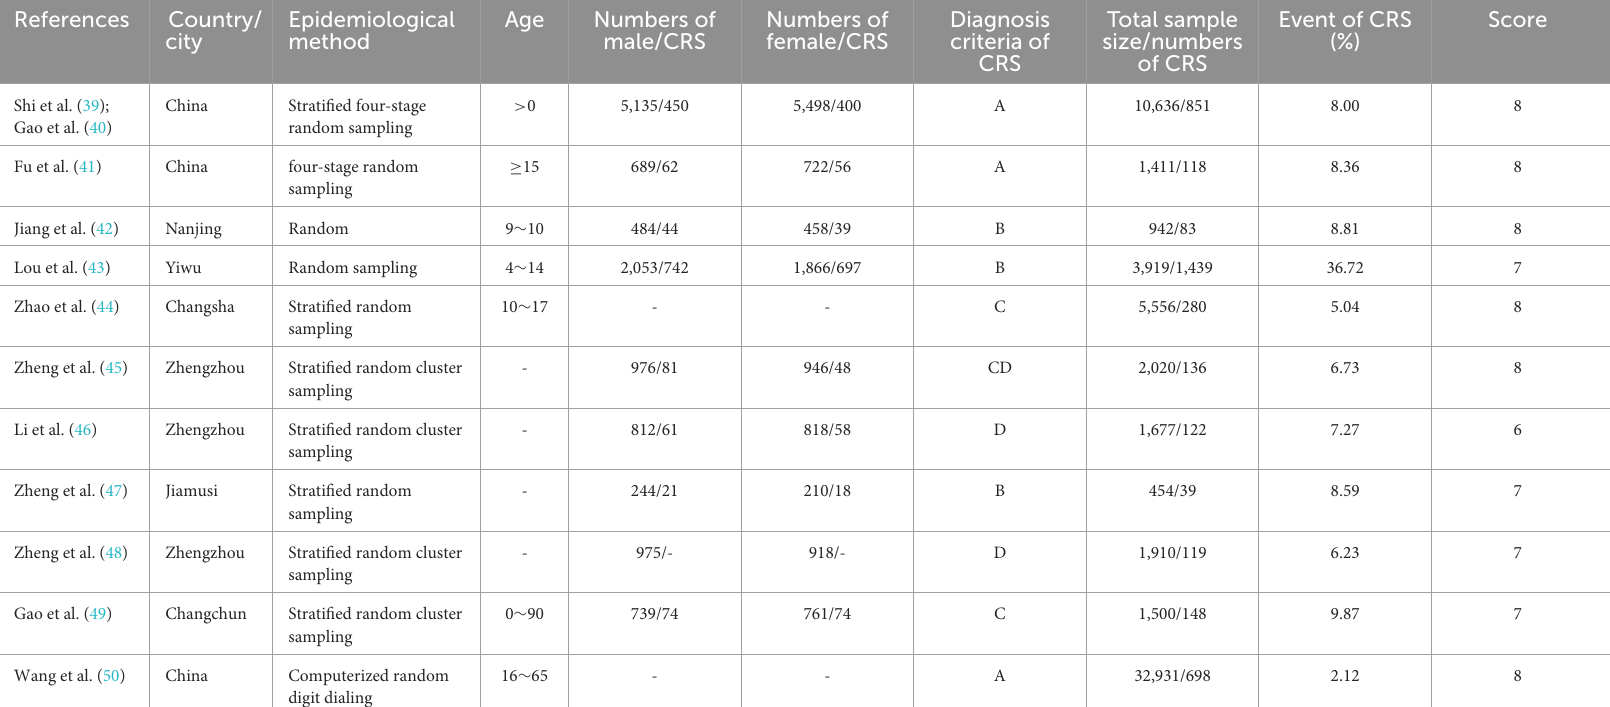
TABLE 1 Characteristics of all included